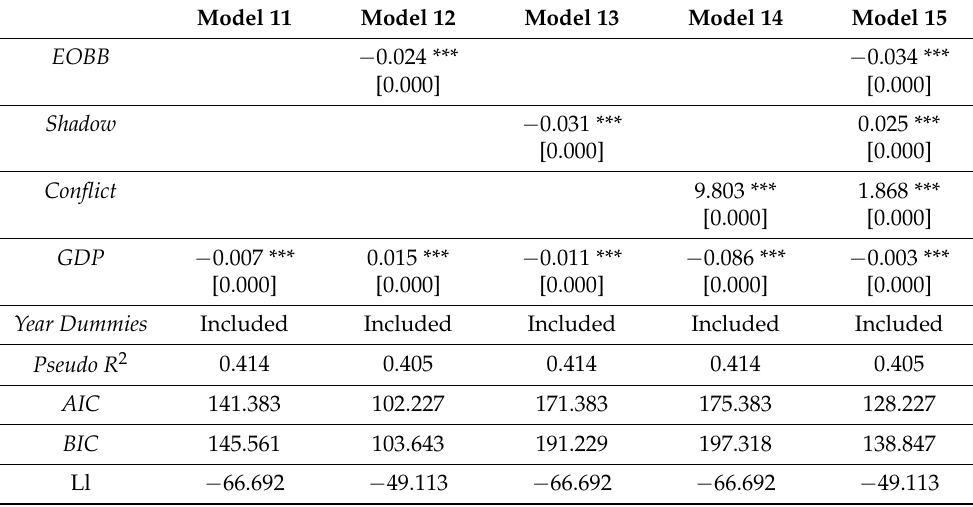
Table 6. Number of Deals involving Ukrainian Targets by Foreign